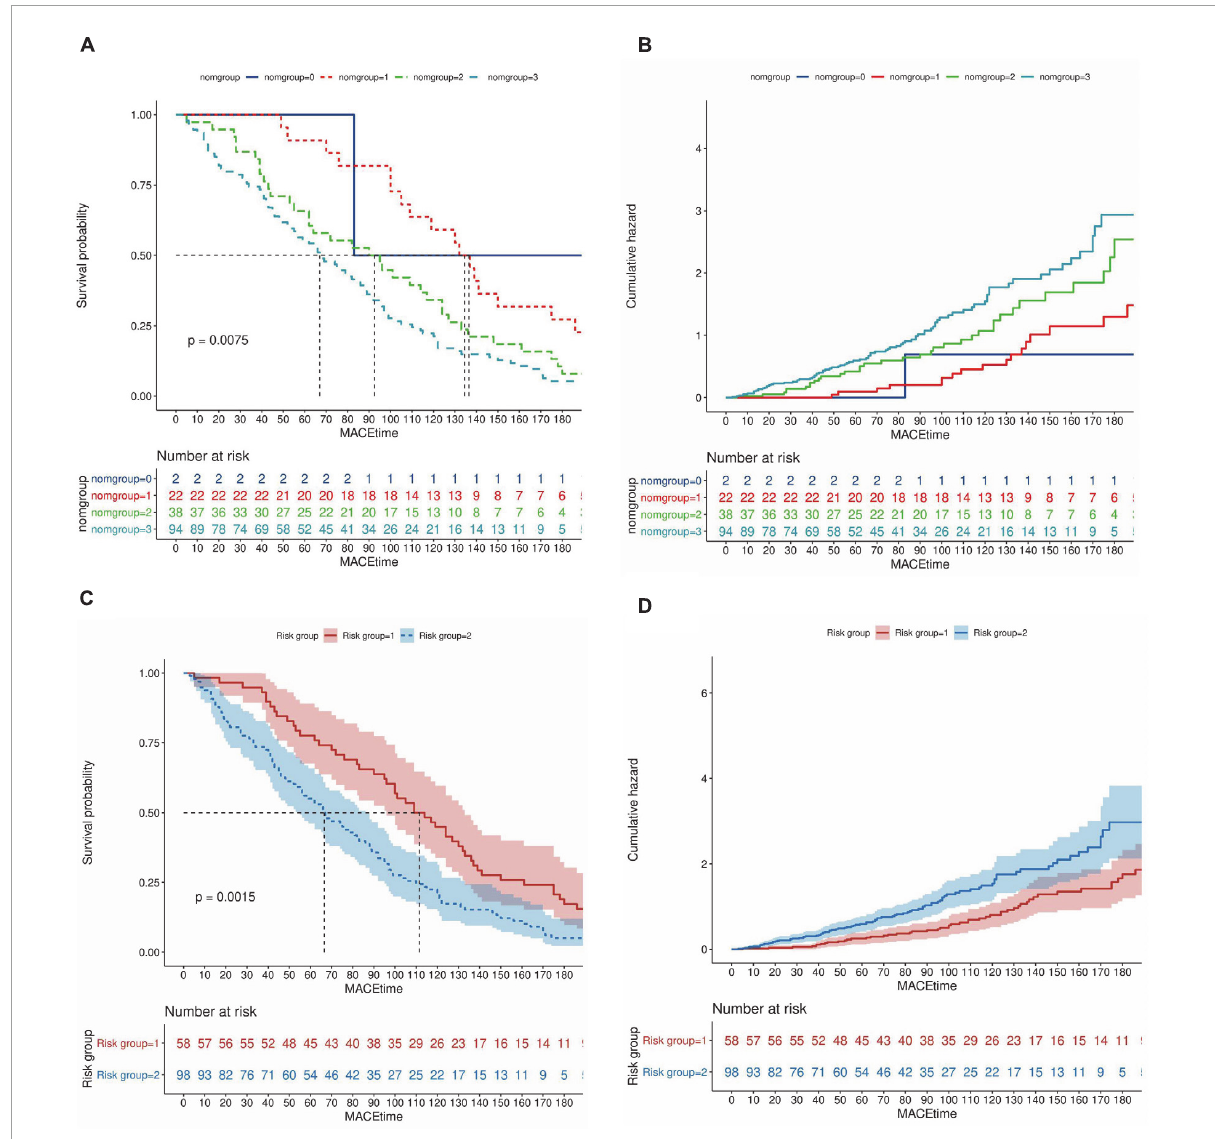
FIGURE6 Survival curves based on nomogram scores and predictive risk. (A,B) Patients were divided into four groups according to the quartile total nomogram scores (nomgroup = 0, 1, 2, 3), the KM survival curves and cumulative survival curves were used to compare survival times among different groups was made by log-rank test. (C,D) Patients were divided into high-‘and low-risk groups (low-risk group = 1, high–risk group = 2) according to the predicted probabilities of the prediction model. The median survival time (LT50) for different groups. The horizontal axis of the KM survival curve represents time, and the vertical axis represents